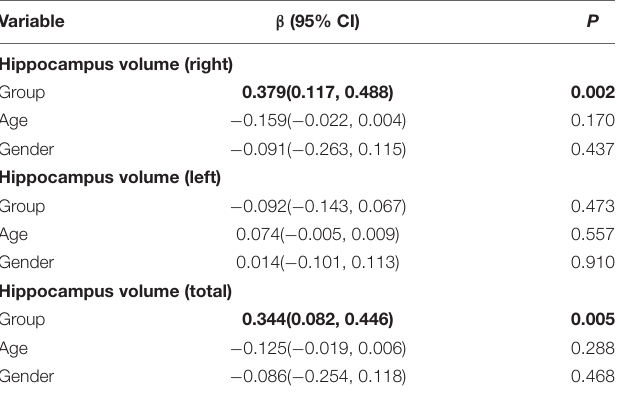
TABLE 2 | Linear regression model of hippocampal volumes and its potential